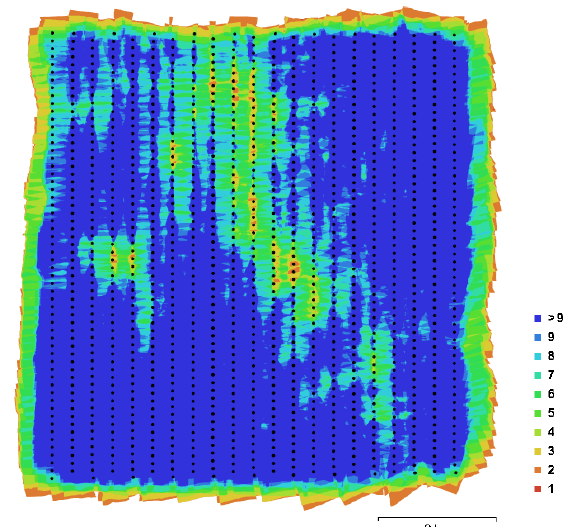
Figure 6. Camera locations and number of image observations of the research area Seven ground control points (K1-K7) were measured under WGS84 coordinate system by using the static networked GPS and the accuracy of the ground control points were at the level of decimetres. Figure 7 shows the positions of the GCPs.